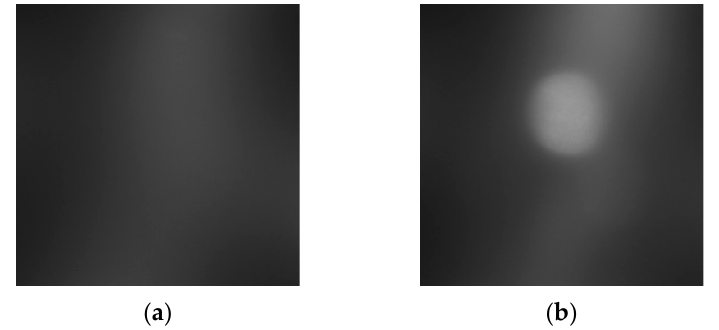
Figure 29. Tactile-sensation images by size: ( a ) 8 mm, ( b ) 12 mm.